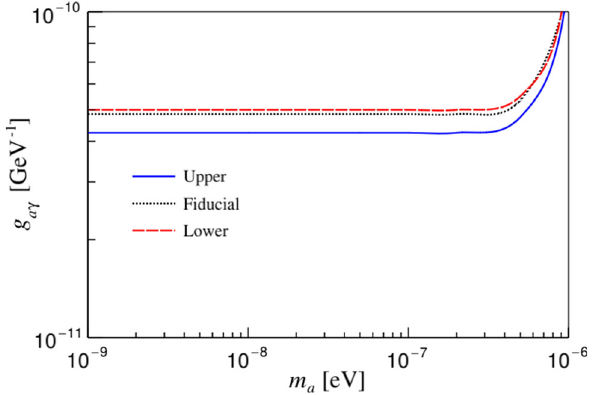
Fig. 12 Variation in the bound due to the different choice of the mag- netic field in the host galaxy. The continuous curve refers to the box model, while the dashed curve corresponds to the cell model while the black curves refer the maximum bound obtained in each model and the red curves refer to the minimum bound. In each case the spread of the bound represents the variation of B T ∈ [ 2 : 8 ] × 10 − 6